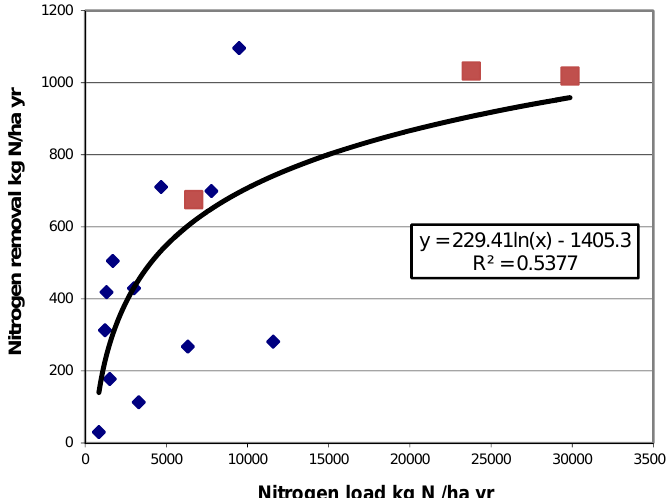
Figure 1. Relationship between nitrogen load and removal (kg per hectare wetland area and year), based on water sampling in inlet and outlet of 15 created wetlands in agricultural areas in southern Sweden. Data from automatic flow proportional water sampling in 3 wetlands and strategic grab sampling in 12 wetlands are indicated with different symbols. The regression model R = 229.41ln(L) − 1405.3, where R = annual nitrogen removal per wetland area (kg ha − 1 yr − 1 ) and L = annual nitrogen load per wetland area (kg ha − 1 yr − 1 ) was used for modelling of nitrogen removal in 60 selected wetlands.